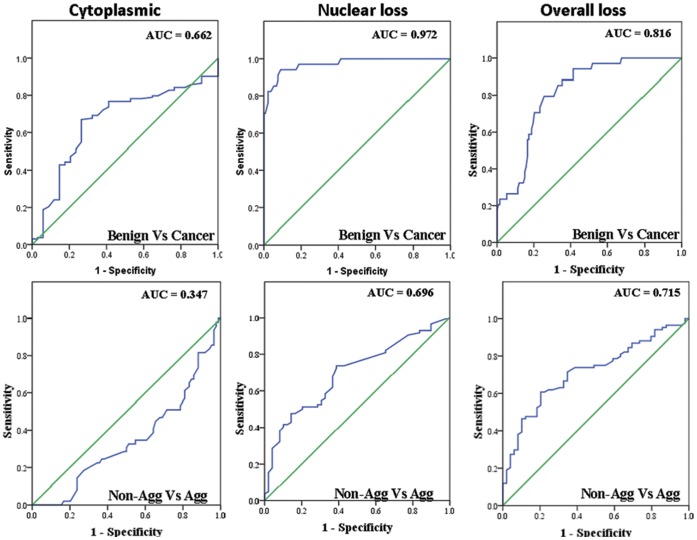
ROC curves analyses of cytoplasmic, nuclear and overall biotinidase expression in thyroid cancers. The vertical axis of each curve indicates sensitivity and the horizontal axis indicates the 1-specificity. The sensitivity, specificity, and AUC values are summarized in Tables 2a and 2b.